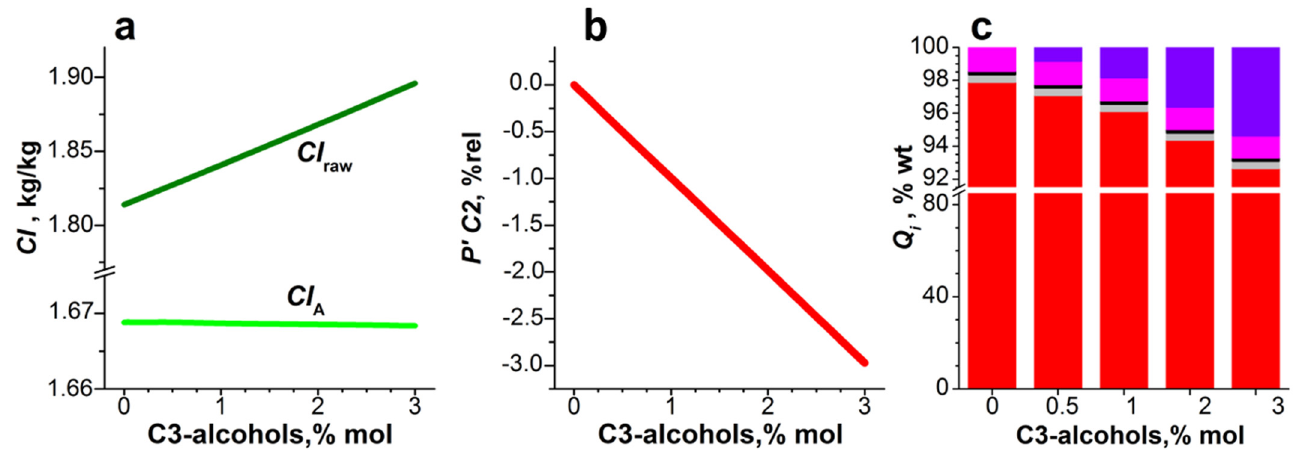
Figure 7. The impact of impurity concentrations on feedstock consumption ( a ), products capacity ( b ) and dry-ethylene quality ( c ) for EtOH -to- C2 process in the MTR . Conditions: #2 in Table 3. —propylene, — C4 , — COx , —ethane, and H 2 , — C2.